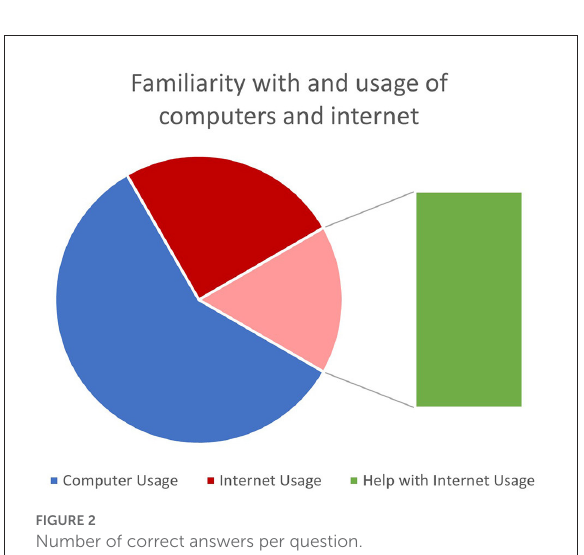
FIGURE2 Number of correct answers per